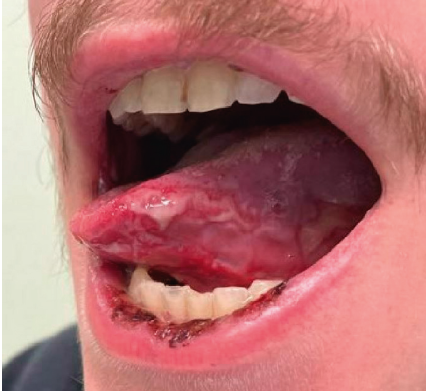
Figure 8: Resolving oral mucocutaneous lesions.